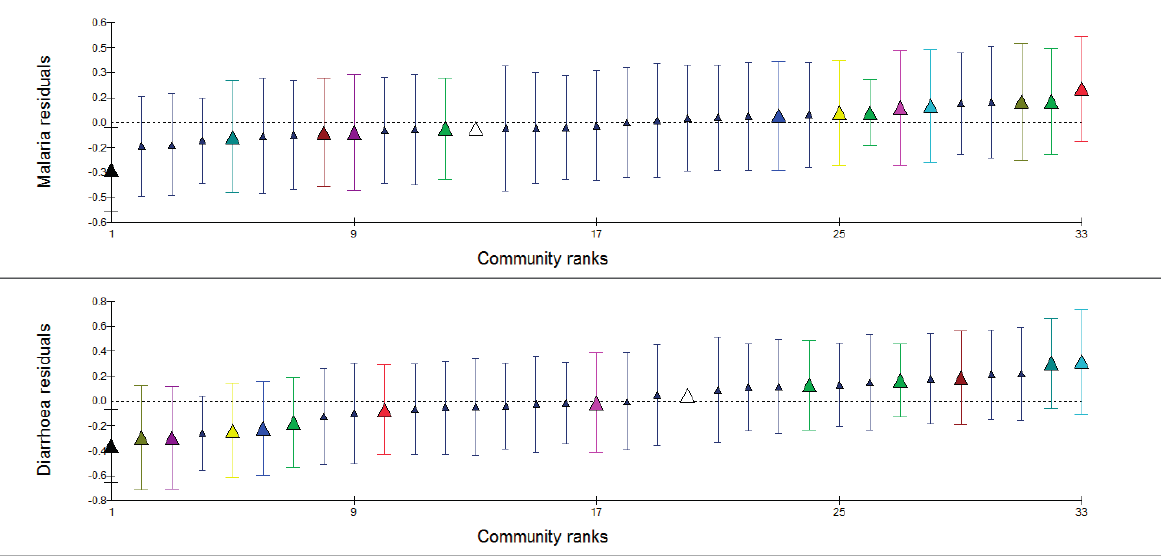
Figure 3. Caterpillar plot of community residuals for malaria and diarrhea prevalence. The triangles indicate estimated (shrunken) community